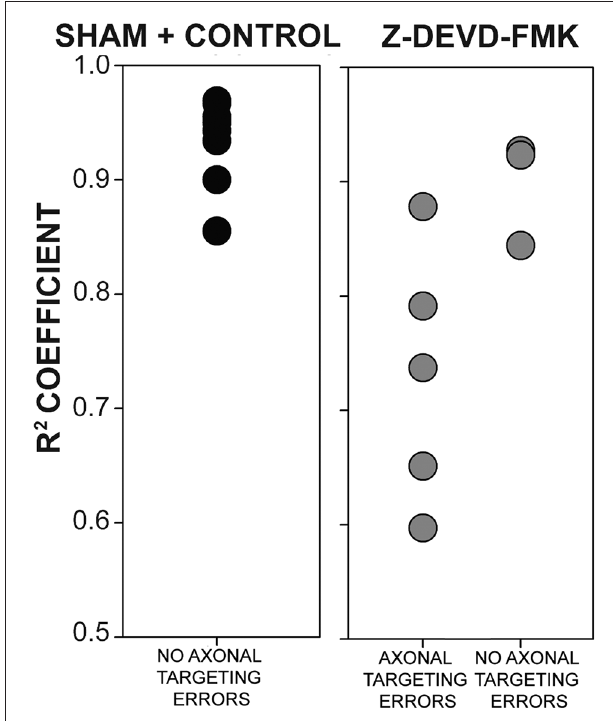
FIGURE 6 | The presence of axonal tract intrusions into NL was associated with greater disorganization of NL lamina. No instances of axonal tract intrusion were seen in the sham + control group, and R 2 coefficient values were correspondingly high. High R 2 coefficient values describe NL with highly organized neuronal deployment. Several instances of axon targeting errors were seen in the Z-DEVD-FMK injected group, although not in all specimens. In instances of targeting errors, R 2 coefficient values were significantly lower than in instances of no axonal targeting errors in sham + control or Z-DEVD-FMK injected